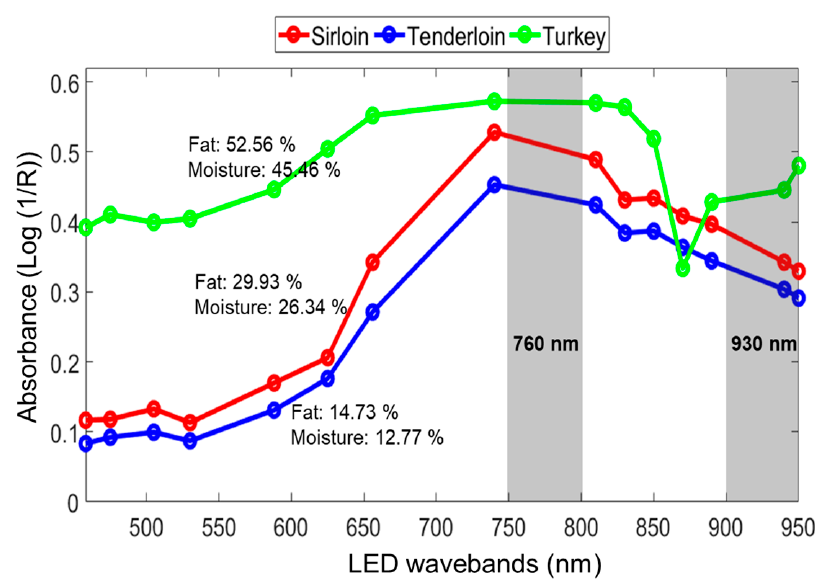
Figure 5. Mean absorbance spectra of three different meat types (sirloin, tenderloin, and turkey).